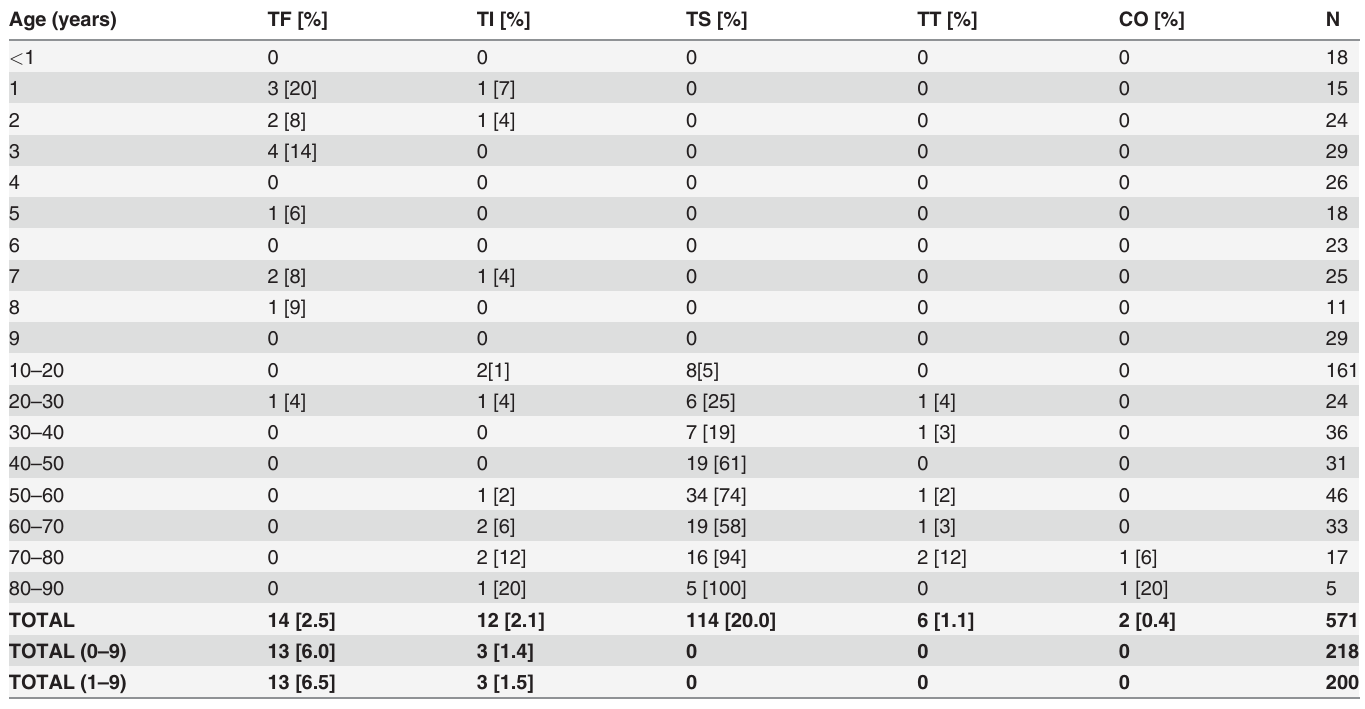
Table 2. Age-speci fi c prevalence of clinical signs of